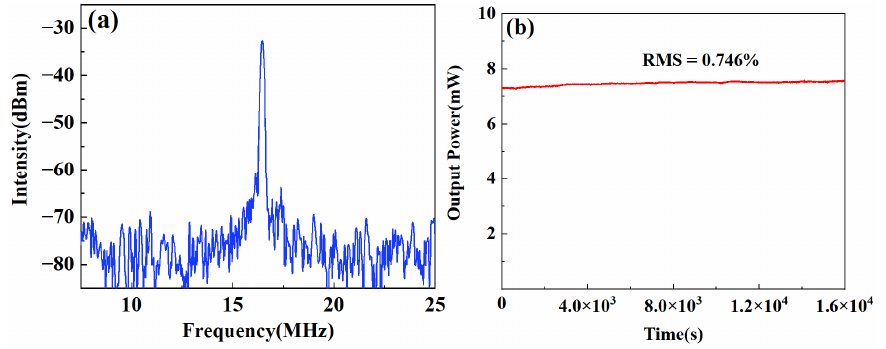
Figure 4. ( a ) RF spectrum at the net intra-cavity dispersion of − 0.002 ps 2 . ( b ) Power fluctuation over 4.5